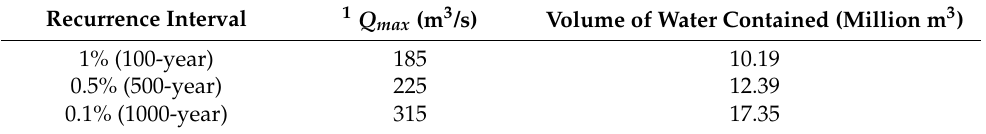
1 Q max (m 3 /s)—maximum inflow rate (m 3 /s) estimated for 1% (100-year), 0.5% (500-year), and 0.1% (1000-year) recurrence intervals according to the hydrological data recorded between 1966 and 2019 at two gauging